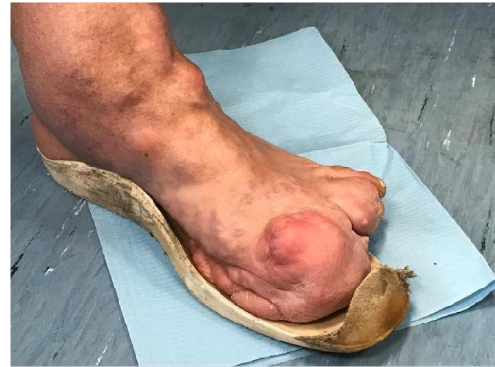
Figure 2. Amputation of the distal phalanges of the first, second, third and fourth fingers, repeated due to